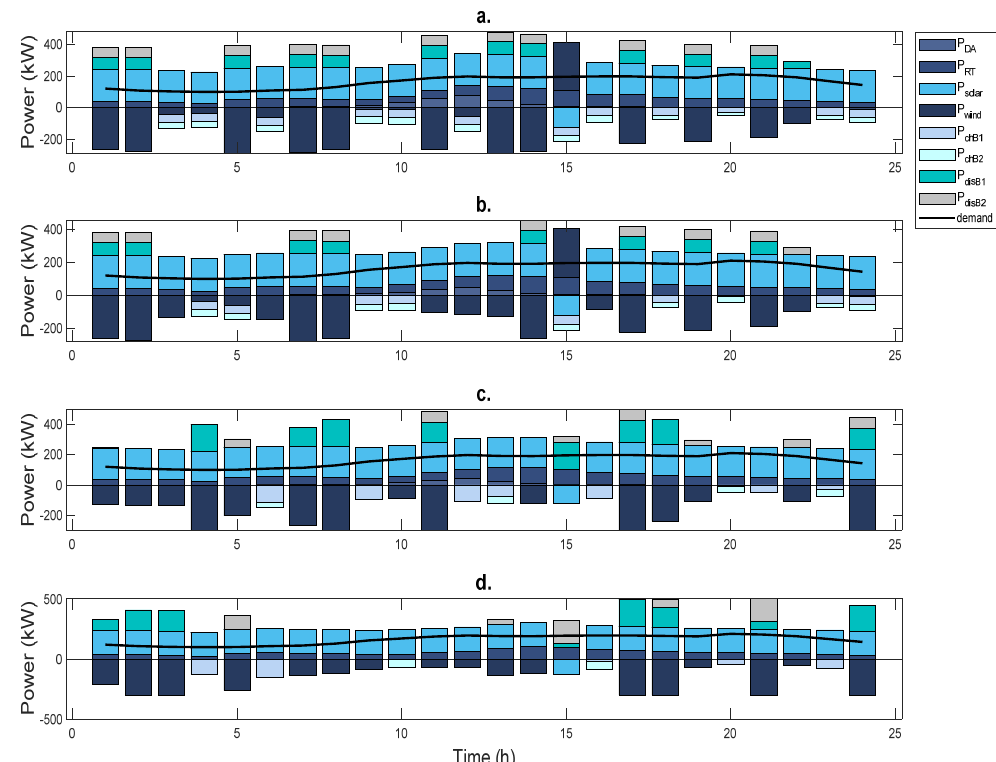
Figure 6. Comparison of optimal dispatches on day 1. ( a ) The VPP offers in the market in real time. ( b ) The VPP bids in the market in real time with a reduction in solar generation of 35.5%. VPP examples when increasing the storage capacity to compensate for the reduction of solar generation to ( c ) 48.1% and ( d ) 98%.